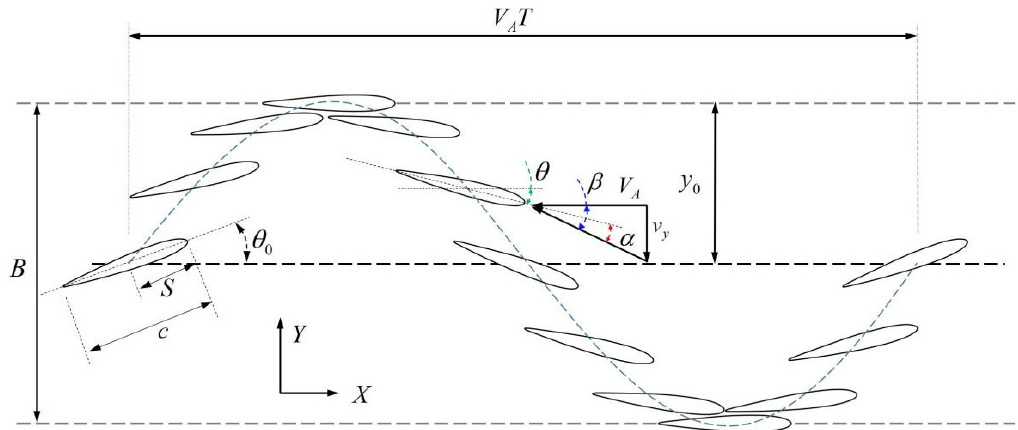
Figure 1. Sketch of the flapping foil propulsor, NACA0012, with combined motions.